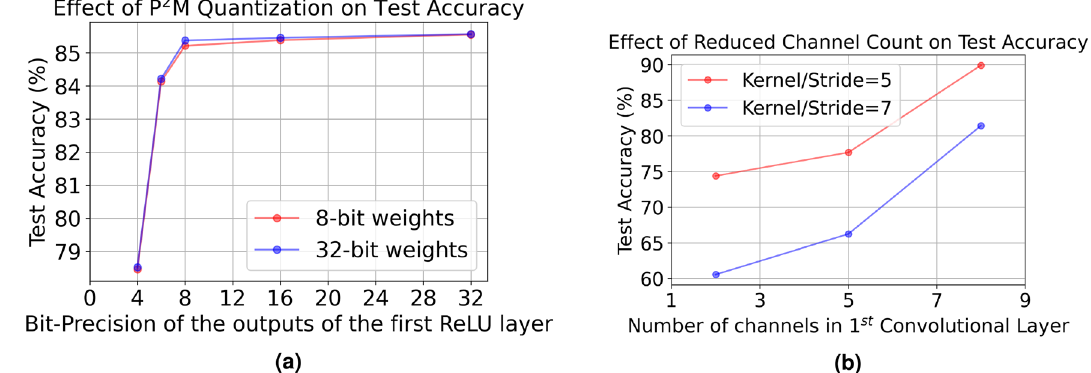
Figure 7. ( a ) Effect of quantization of the in-pixel output activations, and ( b ) effect of the number of channels in the 1st convolutional layer for different kernel sizes and strides, on the test accuracy of our P 2 M custom